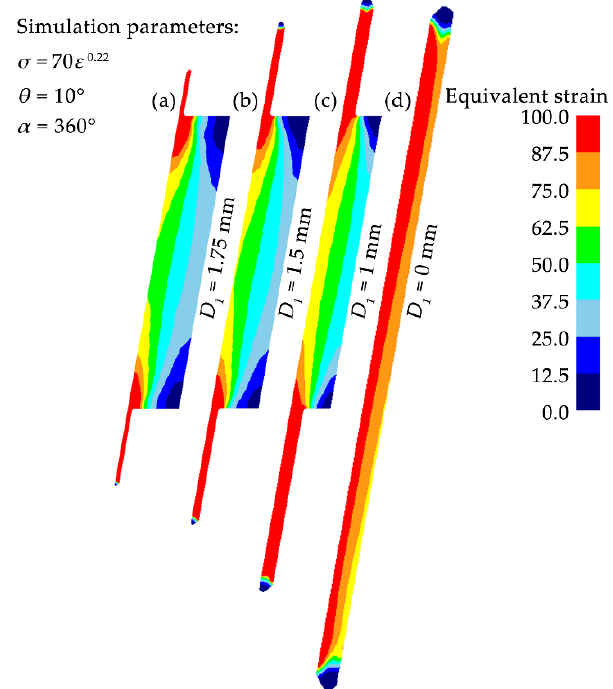
Figure 6. Distribution of equivalent strain across the vertical section of samples at various concave depth during t -HPS: ( a ) D 1 = 1.75 mm, ( b ) D 1 = 1.5 mm, ( c ) D 1 = 1 mm, ( d ) D 1 = 0